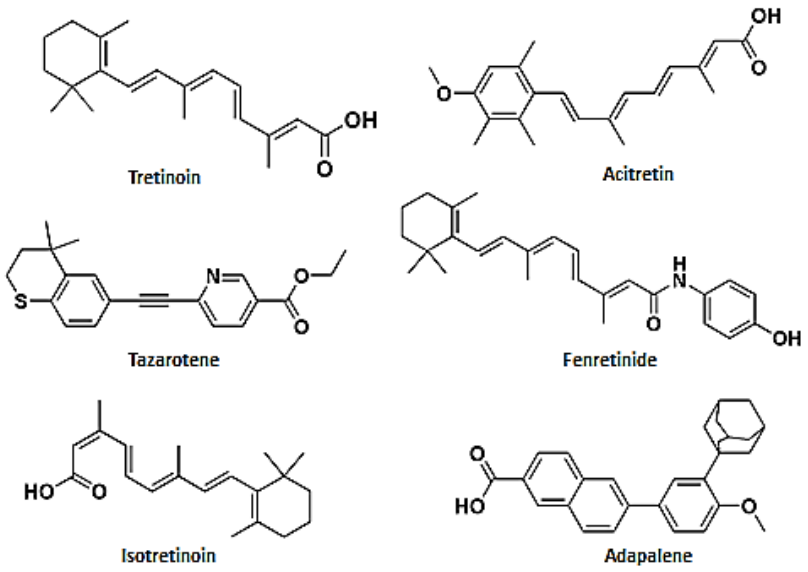
Figure 2. Chemical structures of the active retinoids against mycosis. The sketches were drawn in ChemDraw ® Ultra 7.0. Perkin Elmer Italia S.p.A.